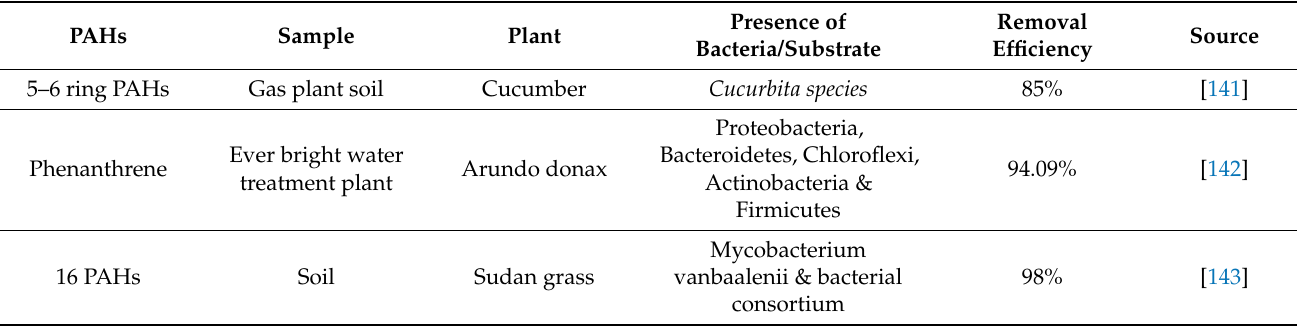
Table 8. Plants used for the removal of PAHs.